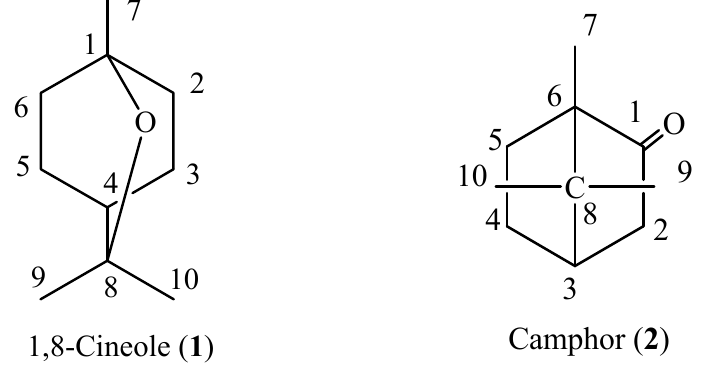
Figure 1. Constituent compounds isolated from the essential oil of Curcuma wenyujin